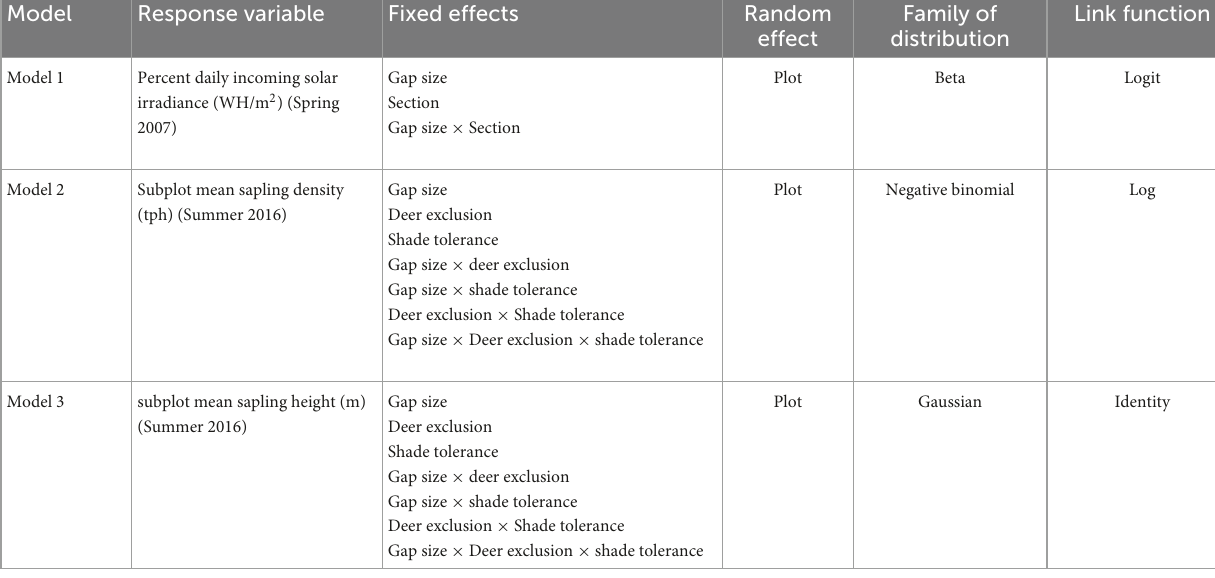
TABLE 3 Mean values of microclimate variables collected May 26–20 September 2008, from the N–S quadrants within the central zone and N-S-E-W quadrants of transition zones of three large subplots that received GSH treatments.